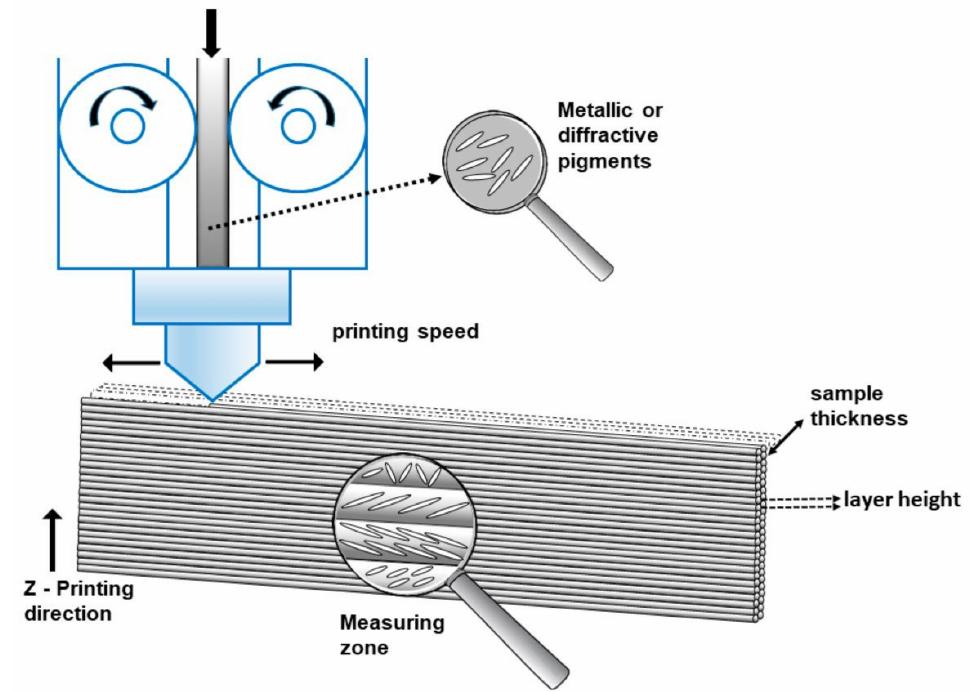
Figure 20. Printing factors schematic with the controlled and changed parameters and the possible disposition of the metallic/diffractive pigments across the printed sample (Reproduced with permission from Reference [166], copyright 2019,